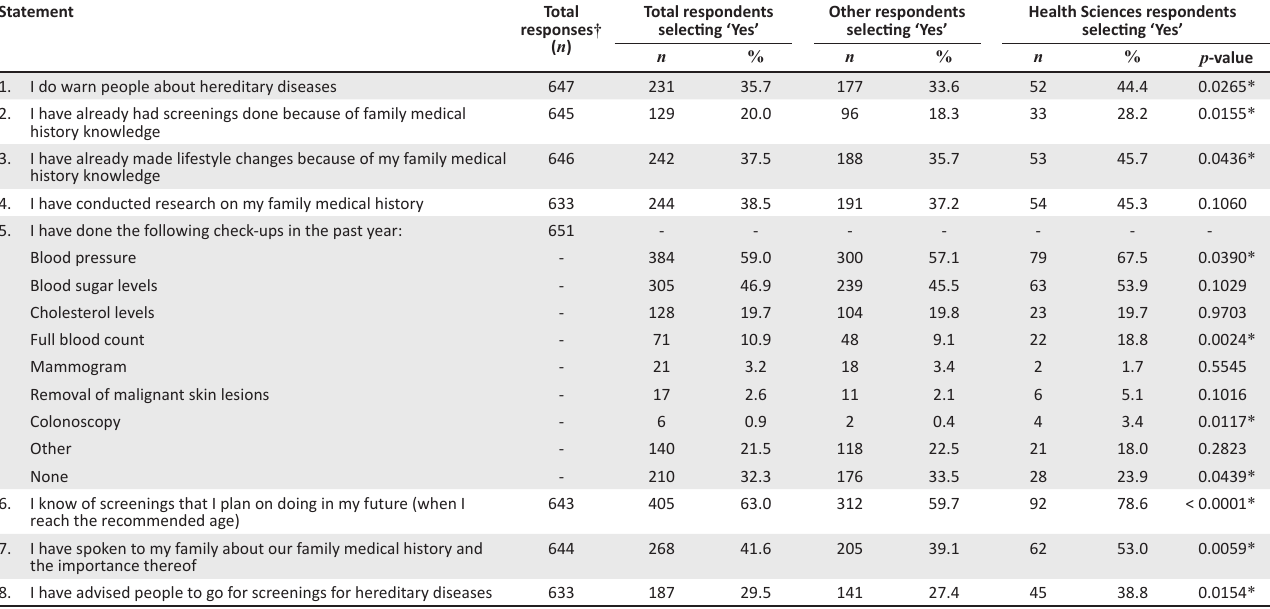
TABLE 5: Respondents’ practices regarding family medical history of hereditary diseases.